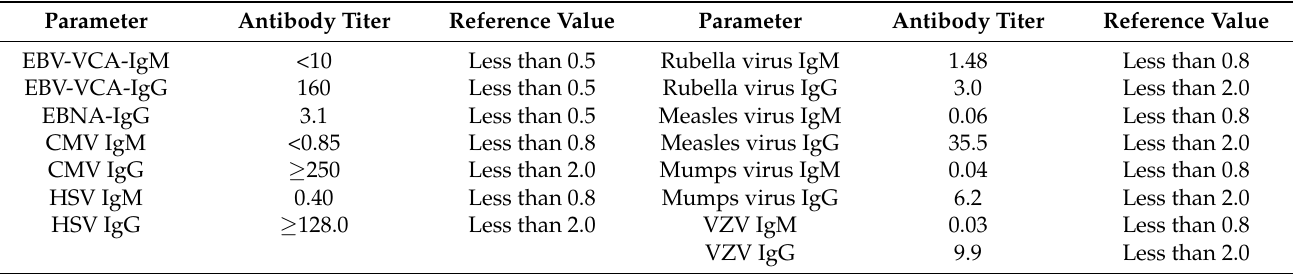
Table 1. Test results for rash-based viral